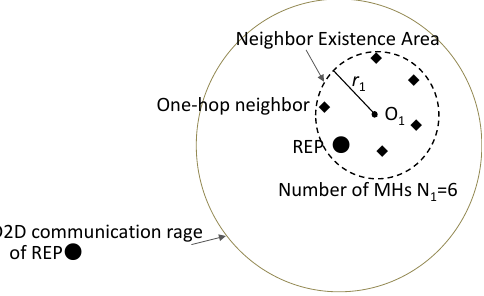
Figure 9. Example of neighbor existence area.